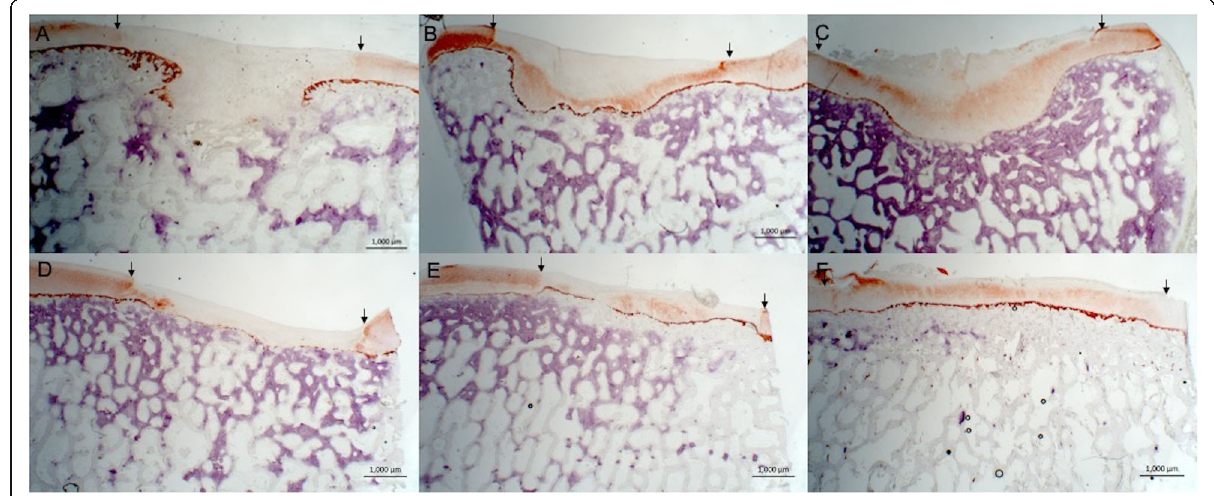
Fig. 9 Collagen II staining; scale bar 1000 μ m. Magnification 12.5-fold. Defects treated with CB ( a-c ) and BMS ( d - f ). Images represent 0 – 25% (left), 25 – 50% (middle) and 50 – 75% (right) positive collagen II